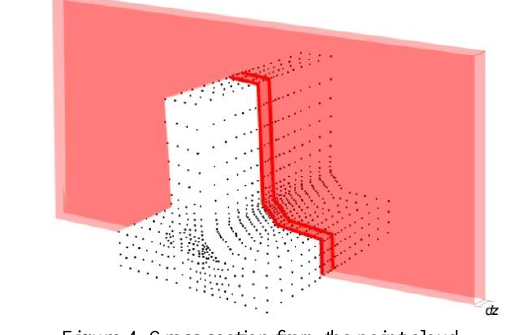
Figure 4. Cross section from the point cloud